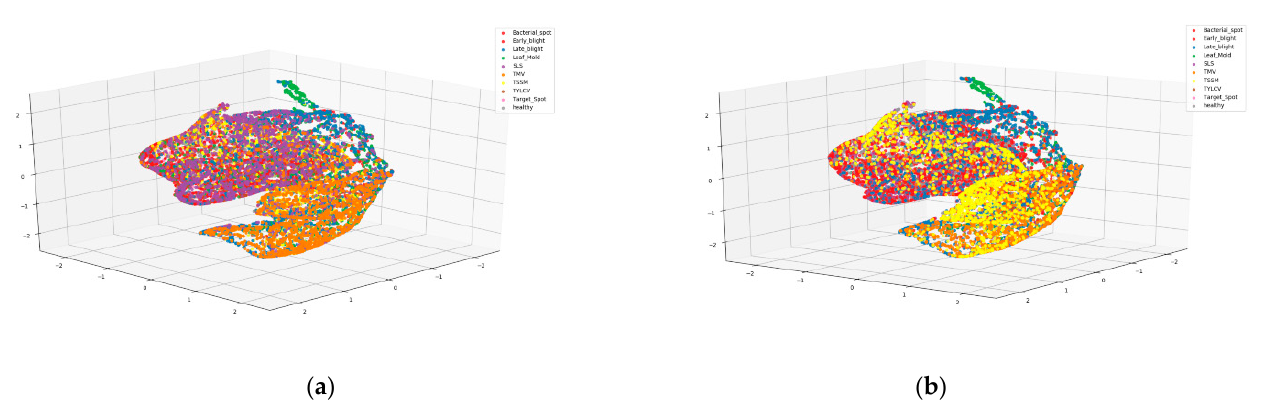
Figure 3. Dataset clustering results based on t-SNE. We can see from ( a , b ) that there is a spatial distance between different clusters (diseases), thus proving that the dataset is divisible.